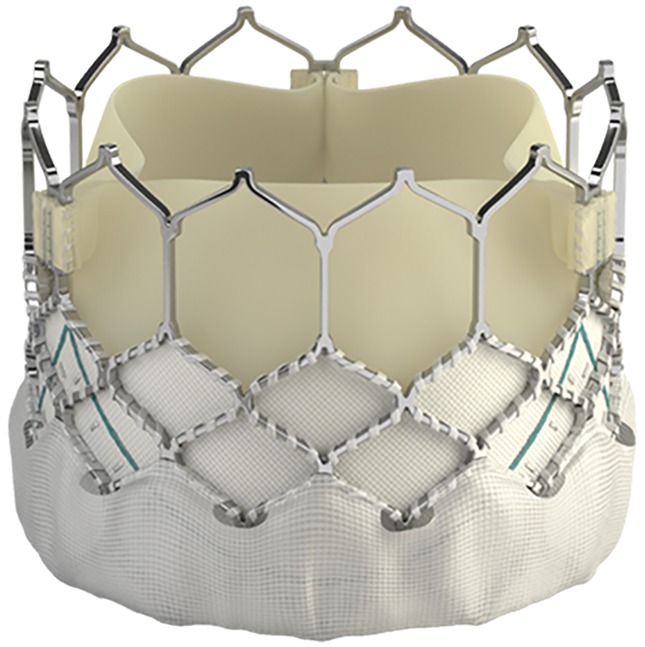
New generation Edwards Sapien 3 valve with the outer skirt (polyethylene terephthalate) to reduce paravalvular aortic regurgitation.